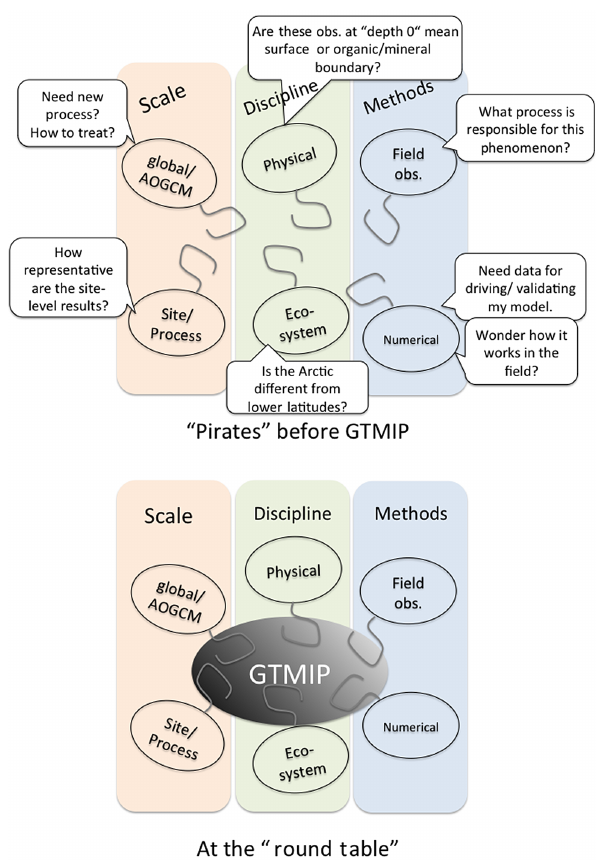
Figure 1. “Pirates of the Arctic” sit at the round